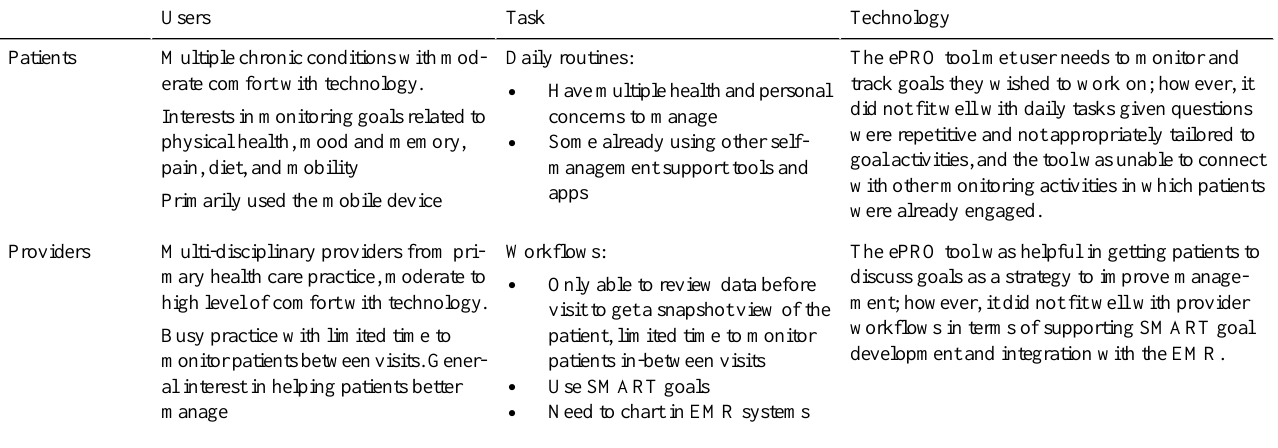
Table 4. Feasibility and usability assessment